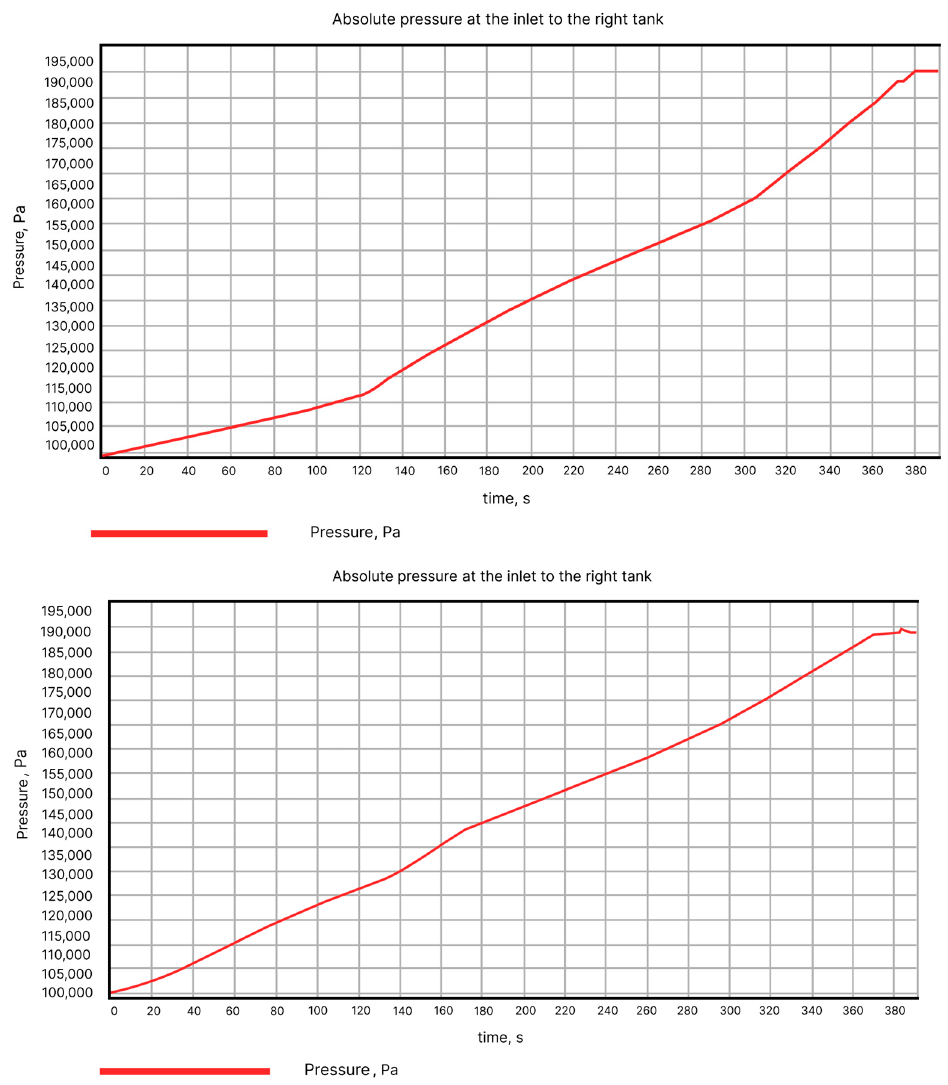
Figure 8. Absolute pressure at an inlet to left and right engines in refueling mode.